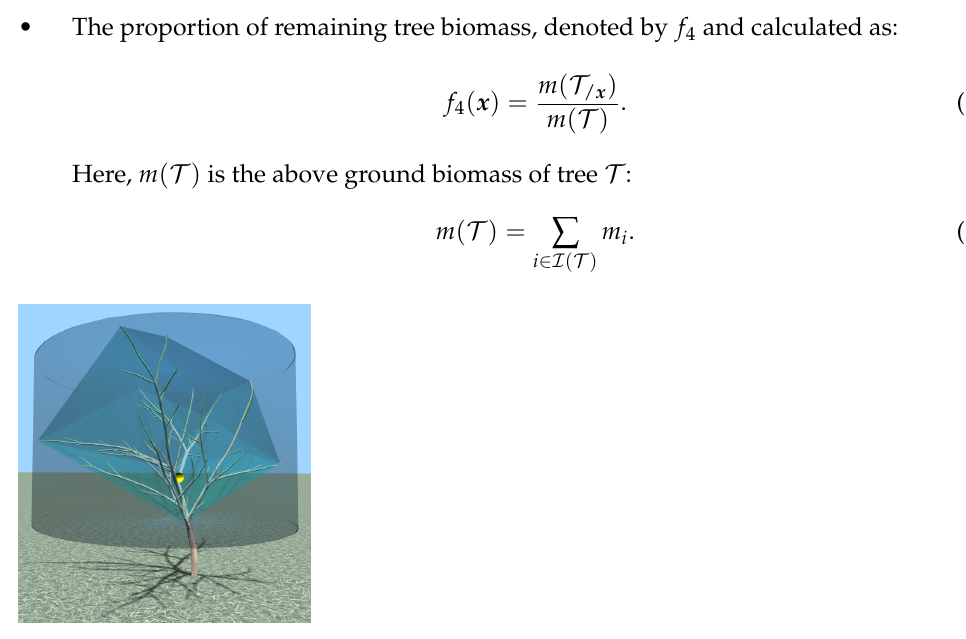
, and the center of gravity c (yellow sphere) for C